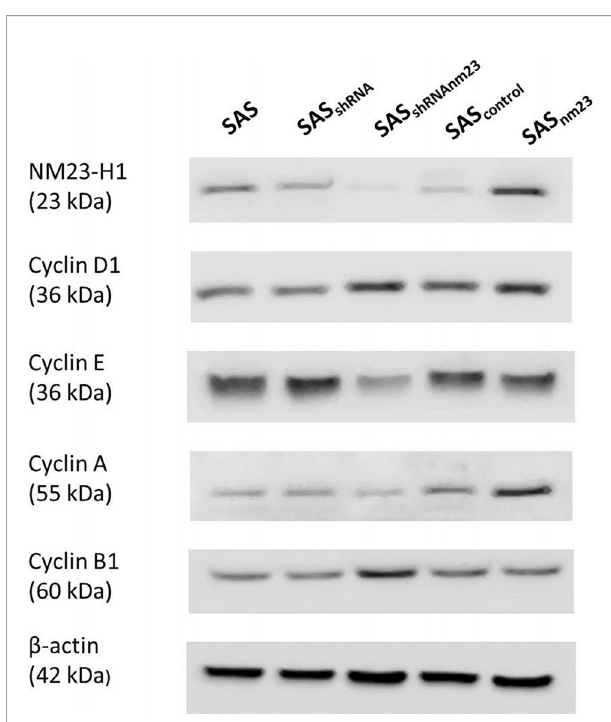
FIGURE 3 | Western blot of NM23-H1 and cyclin D1, E, A1, and B1 in the SAS head and neck squamous cell carcinoma clones. Knockdown of NM23- H1 downregulated cyclin E and A, and upregulated cyclin D1 and B1 in SAS shRNAnm23 cells, compared with SAS shRNA . SAS, parent SAS clone; SAS shRNA , mock knockdown clone; SAS shRNAnm23 ,NM23-H1 knockdown clone; SAS control , mock overexpression clone; SAS nm23 , NM23-H1 overexpression